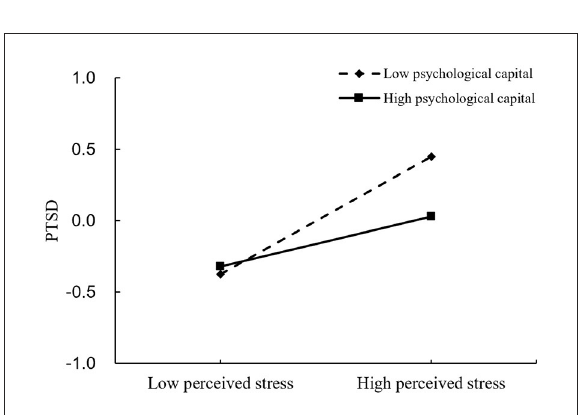
FIGURE4 Association between perceived stress and PTSD symptoms at higher and lower levels of psychological capital.